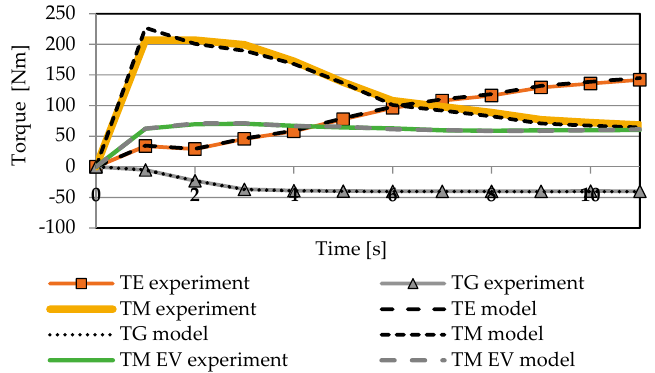
Figure 5. Torque of the internal combustion engine, the electric motor and the generator versus time.